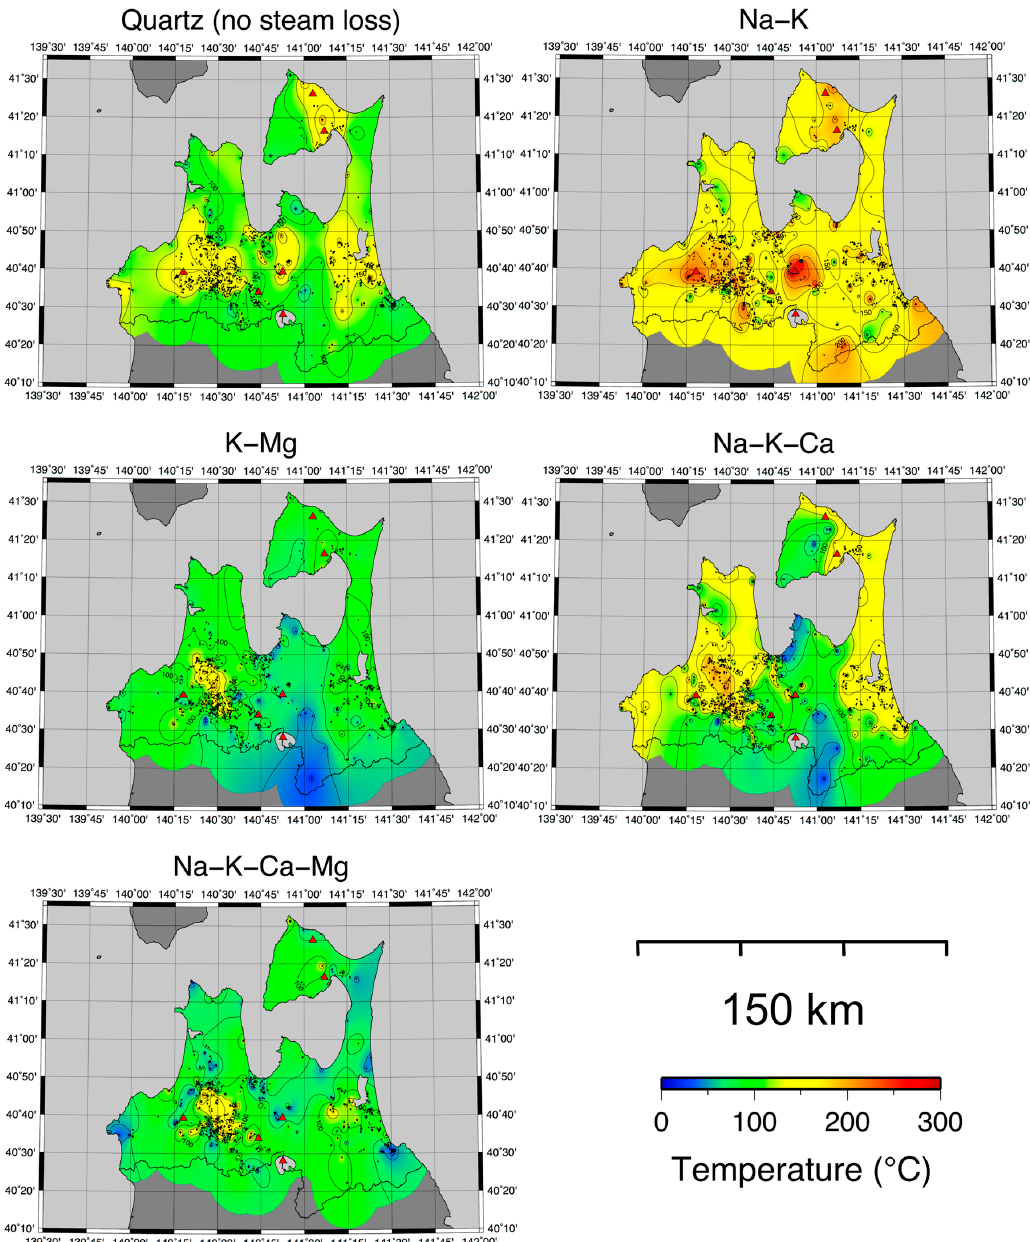
Figure 3. Distribution maps for major solute geothermometers. Black dots indicate data locations and red triangles indicate the locations of major Quaternary volcanoes and calderas.